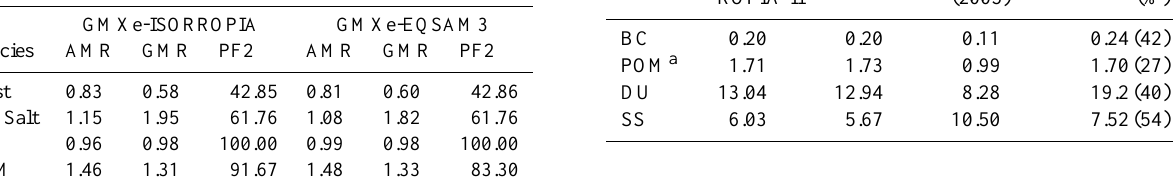
Table 3. Summary of the comparison of model data (2001 and 2002) to observations of bulk species (as shown in Fig. 8 with simulations performed using ISORROPIA and EQSAM3 to treat gas/aerosol partitioning). AMR is the arithmetic mean of the mod- elled values/the arithmetic mean of the observed values; GMR is the geometric mean of the modelled values/the geometric mean of the observed values; PF2=Percentage of modelled points within a factor of two of the observations.